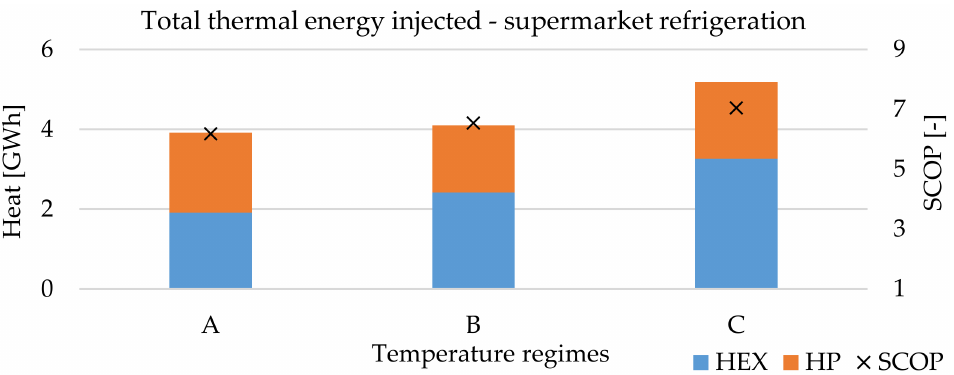
Figure 15. Seasonal COP and total supermarket refrigeration waste heat used concerning different DH network temperature regimes, for the selected connection pipe